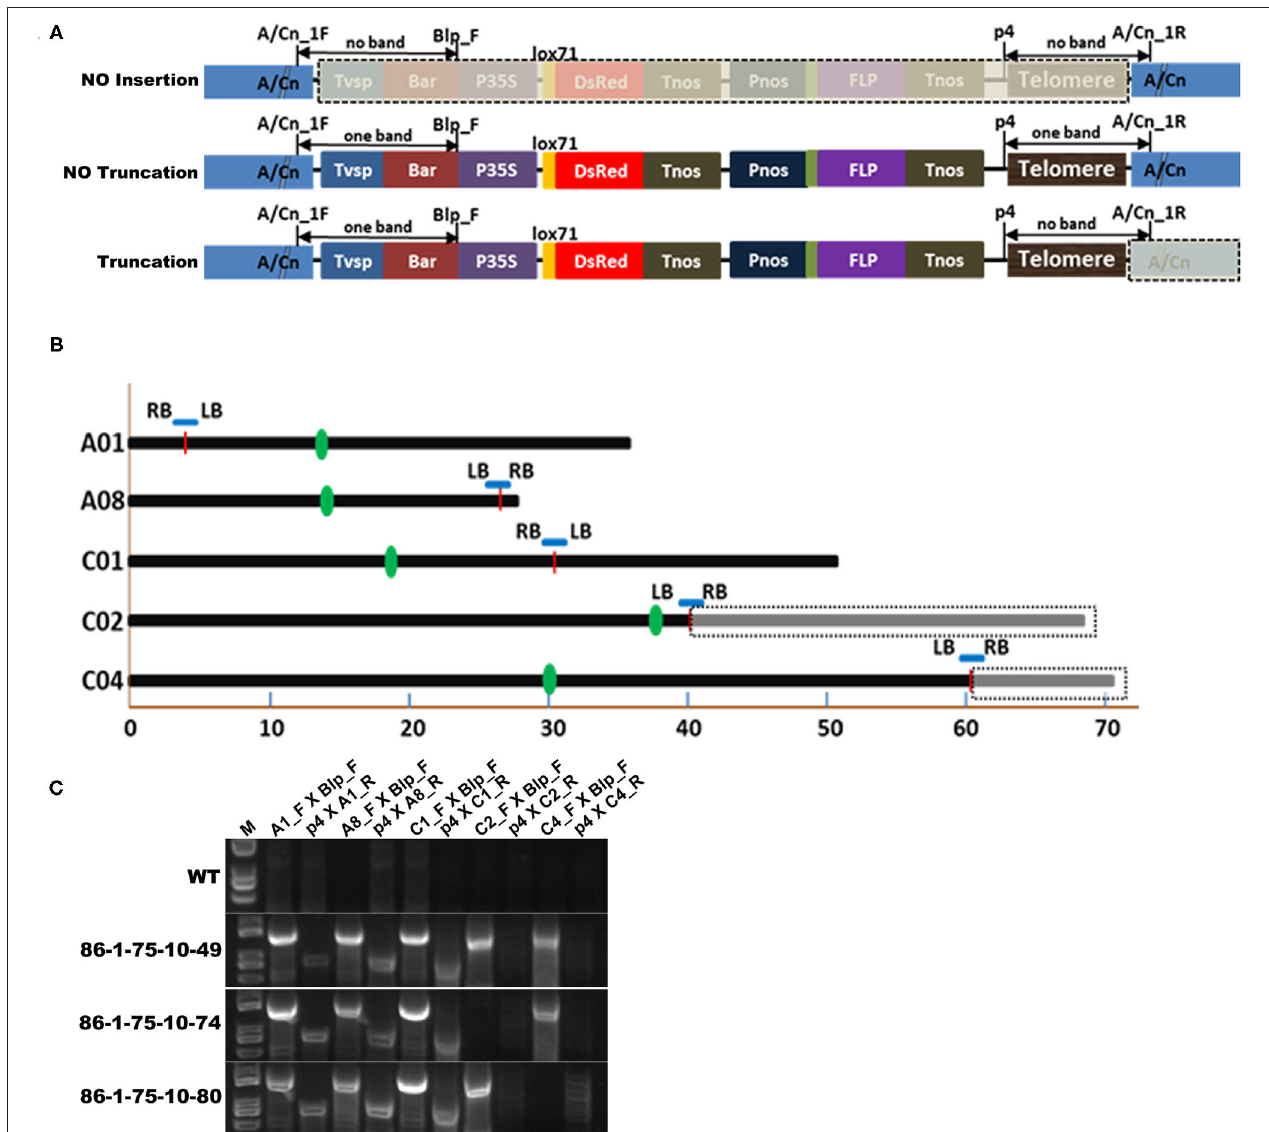
FIGURE 5 | Confirmation of truncation positions by genome resequencing analysis and insertion site-specific PCR. (A) Schematic diagram depicting confirmation of the truncation on chromosomes by insertion site-specific PCR. A/Cn indicate the chromosome An or Cn. The forward primer binding to the flanking sequence near LB of pWY86-1 of the potential insertion site was A/Cn_F. And the reverse primer binding to the flanking sequence near RB of pWY86-1 was A/Cn_R. Blp_F ( Supplementary Table 1 ) was paired with A/Cn_F, and p4 ( Figure 4 and Supplementary Table 1 ) was paired with A/Cn_R. When there was no insertion on chromosome A/Cn, no bands occurred using the two primer pairs (Blp_F with A/Cn_F and p4 with A/Cn_R); when there was one insertion but no chromosome truncation, one band occurred using the two primer pairs; when there was one chromosome truncation event, one band occurred using primer pairs Blp_F and A/Cn_F, but no band occurred using primer pairs p4 and A/Cn_R. (B) Five potential insertion sites in 86-1-75 by genome resequencing analysis according to the reference genome Bra_napus_v2.0 (https://www.ncbi.nlm.nih.gov/assembly/GCF_000686985.2/). Three progeny (86-1-75-10-49, 86-1-75-10-74, and